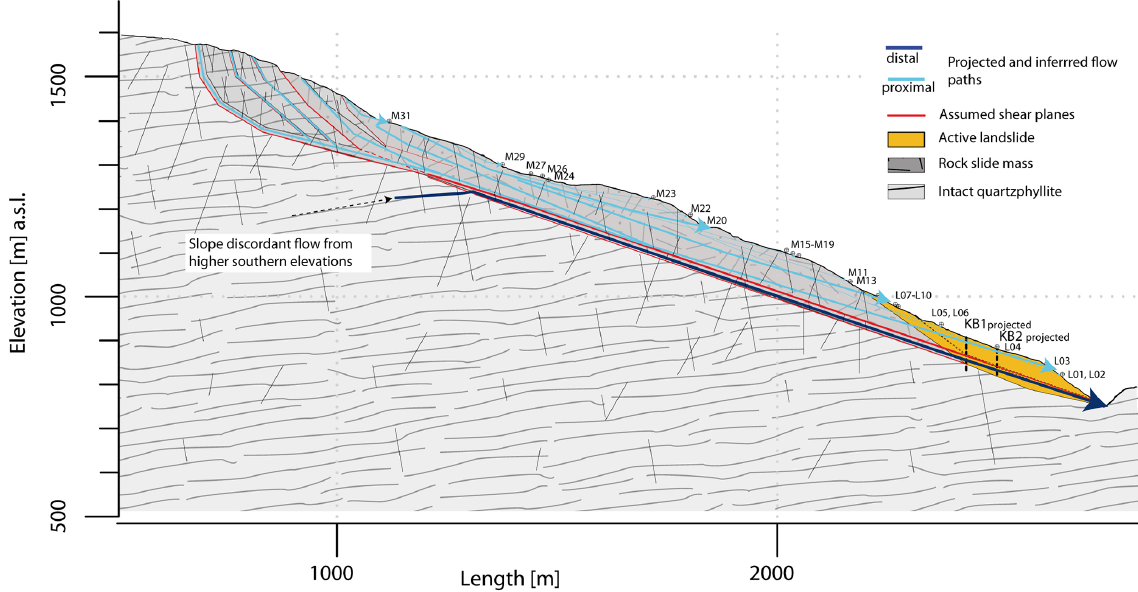
Figure 11. Conceptual hydrogeological model summarizing dominant groundwater flow systems along a transect through the DSGSD and Vögelsberg